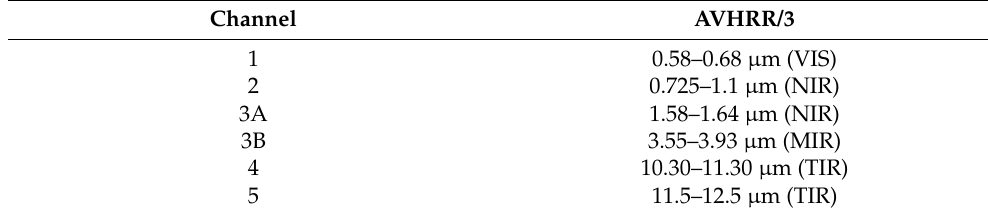
Table 2. Information of the bands of the AVHRR/3 instrument.